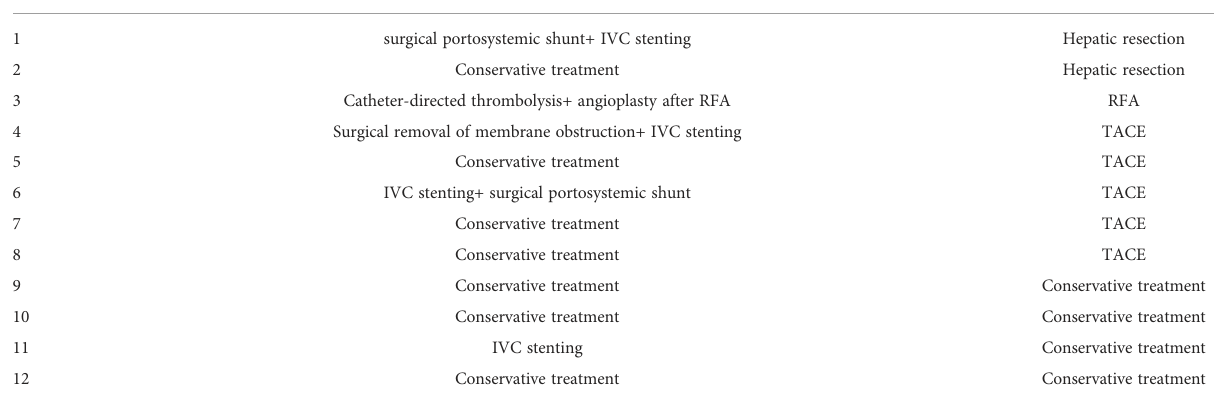
TABLE 6 Treatment of HCC and BCS in 12 patients with HCC.